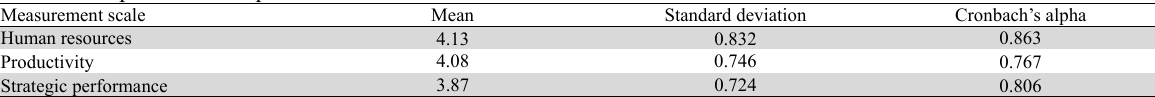
Cronbach’s alpha and descriptive statistics of the measurement scales Measurement scale